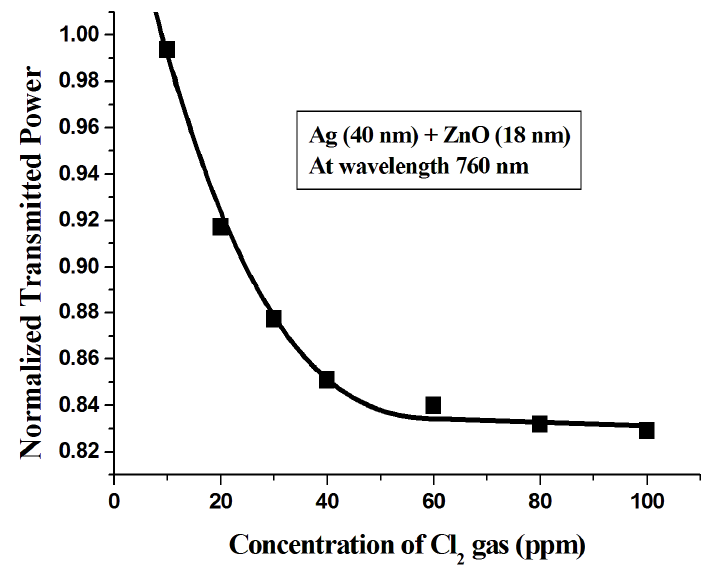
Figure 7. Variation of normalized transmitted power at 760 nm as a function of concentration of chlorine